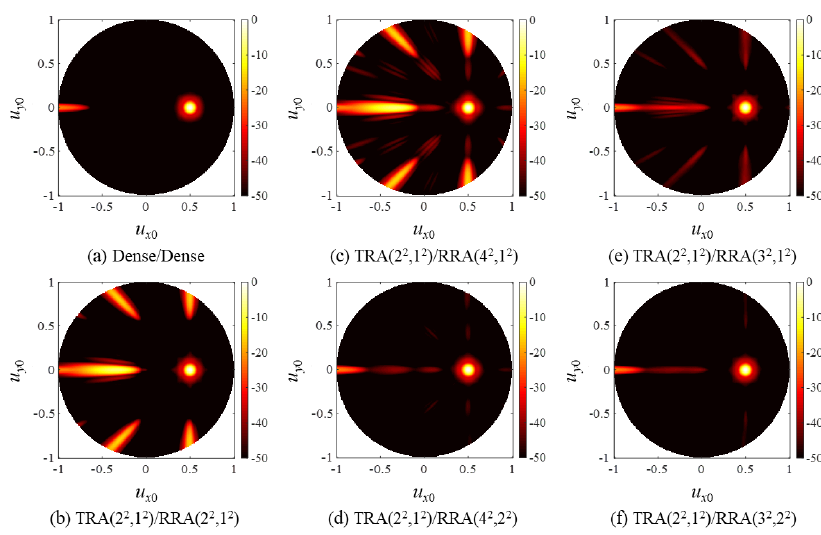
Figure 9. PW PSFs of ( a ) the dense array pair and ( b – f ) the SRA pairs for a steered focal point at ( u x f , u y f ) = (0.5,0) (i.e., θ f = π / 6, and ϕ f = 0).